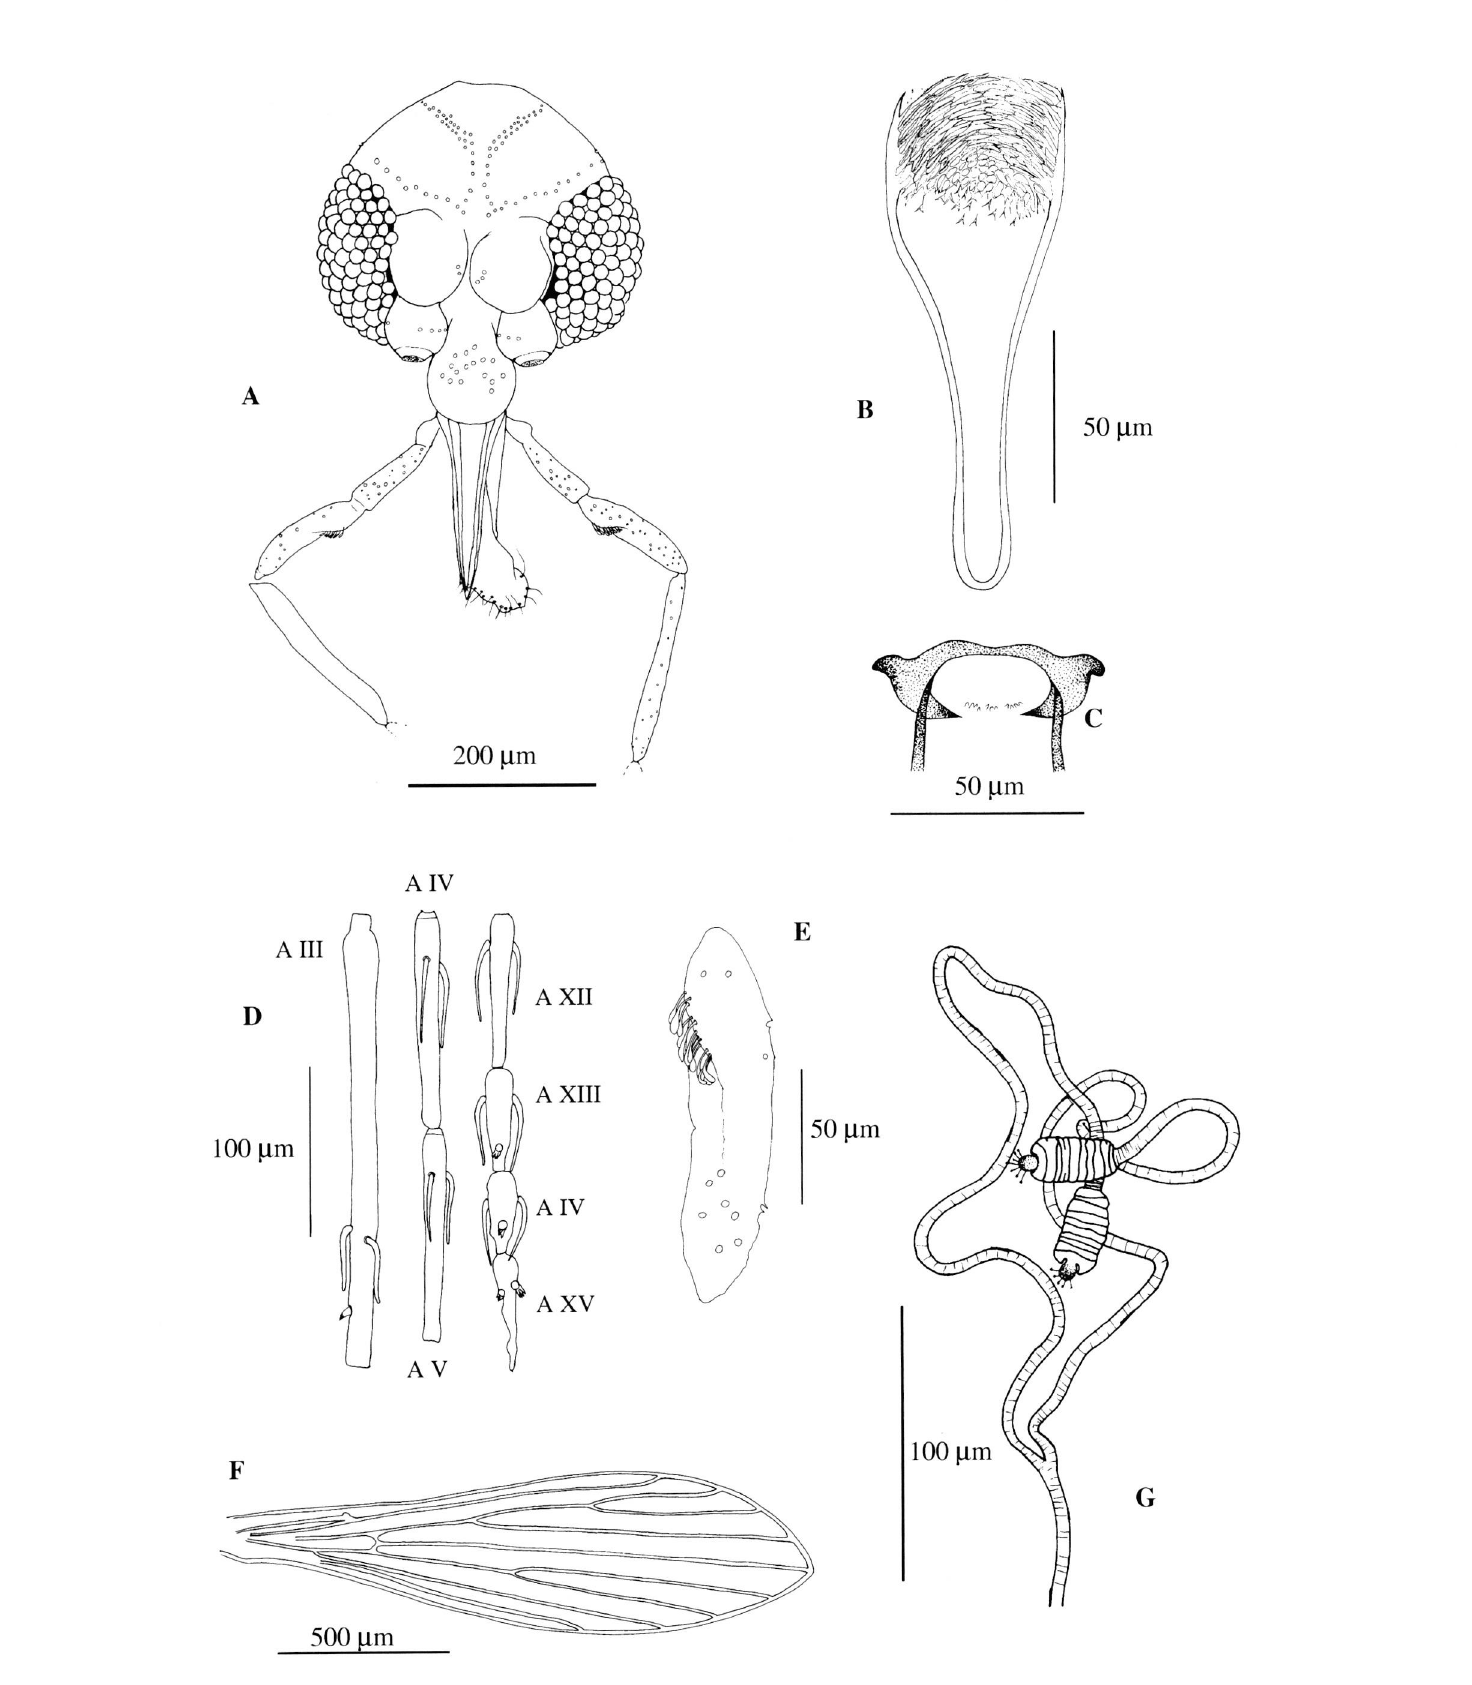
Fig. 3. - P. huberti femelle. A : tête ; B : pharynx ; C : cibarium : D : segments antennaires III. IV. V, XII, XIII, XIV et XV ; E : troisième segment palpaire : F : aile ; G : spermathèques